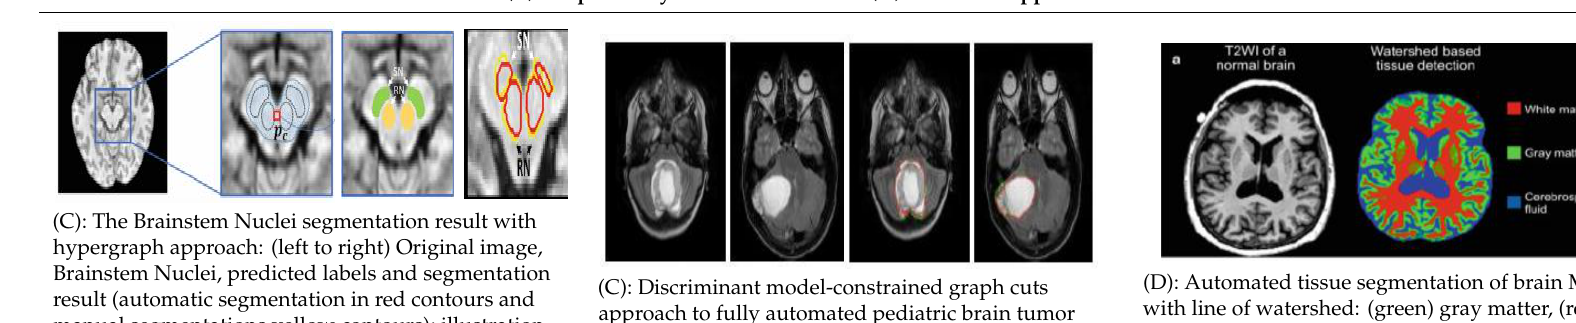
(C) Graph theory based methods and (D) Structural approach based